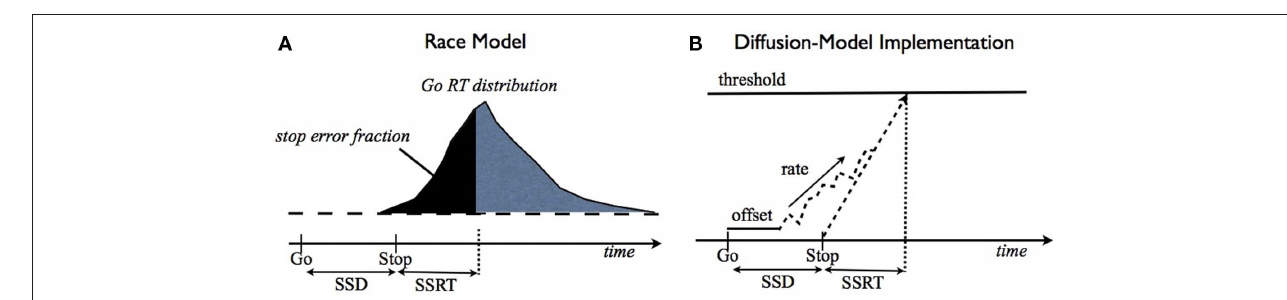
(Verbruggen and Logan, 2009b). The go process consisting of a constant drift rate corrupted by additive Wiener (Gaussian, white) noise on each time step, a temporal offset (also known as the non-decision time), and a threshold for evoking the go response. The stop process is assumed to initiate at a time SSD after the go stimulus, and to take a time of SSRT (assumed to be fixed here) to reach the threshold. Whichever process finishes first determines trial outcome: go or